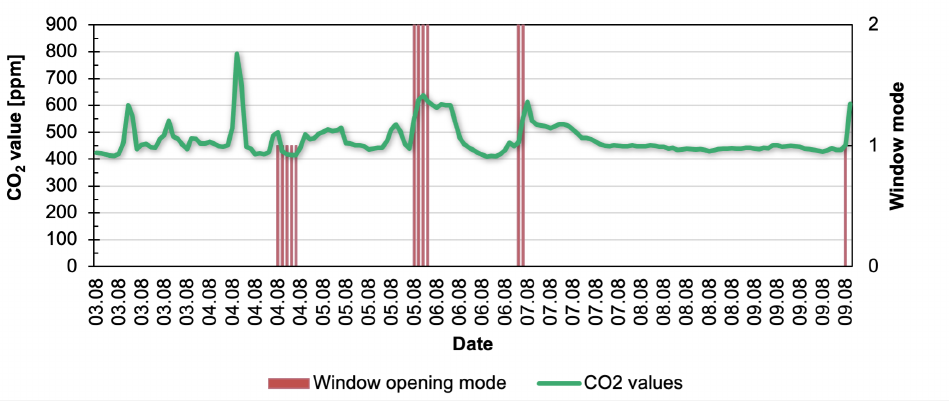
Figure 5. Measured values in the bedroom (CO2 and window